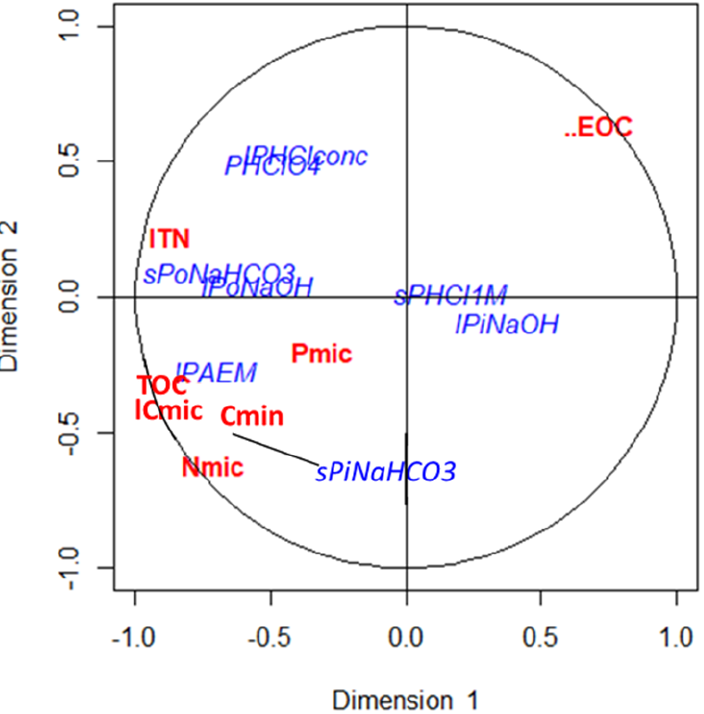
Figure 6. Variables plot for the first canonical dimension of the Canonical Correlation Analysis performed to the P fractions and the soil parameters related to organic matter. Abbreviations for soil parameters as in Table S2.